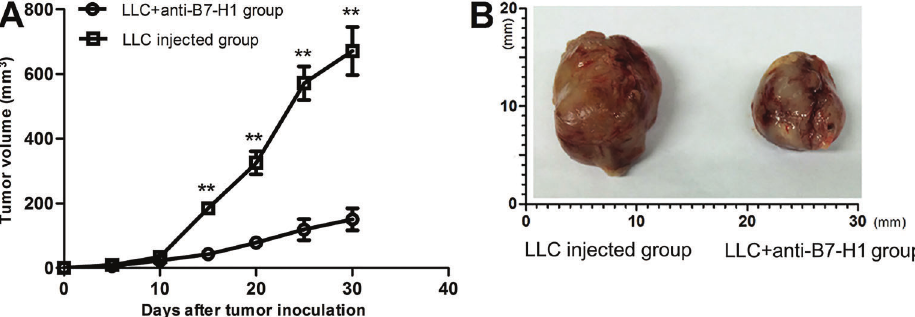
Figure 2. Anti-B7-H1 antibody inhibition of tumor growth in vivo. Lewis lung carcinoma (LLC) cells were subcutaneously injected into C57BL/6 mice to form xenograft tumors. Anti-B7-H1 or vehicle control (LLC injected group) was administered intravenously every 5 days thereafter. A , Tumor growth was monitored every 5 days by calculating tumor area, which was compared between the anti-B7-H1 and control groups. **P o 0.01, compared with the control group (ANOVA). B , Representative images of xenograft tumors on day 30 after LLC injection in the control and anti-B7-H1 groups.